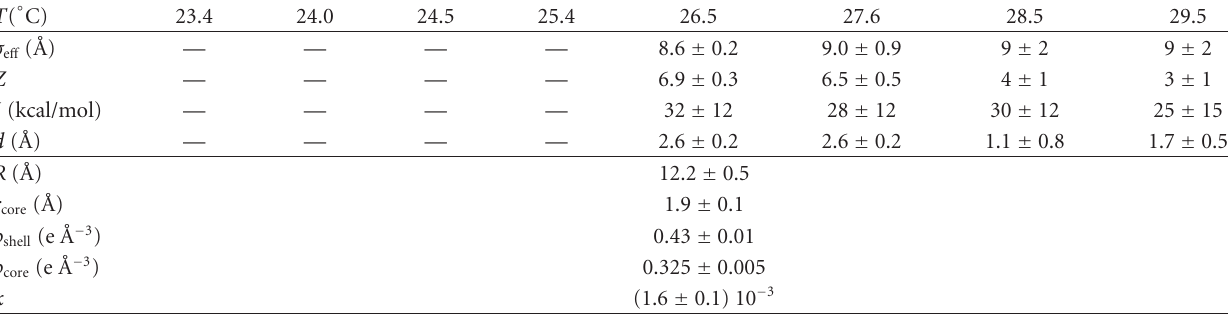
Table 2: Single and common parameters obtained by the global-fitting procedure applied to the 8 experimental SAXS curves shown in Figure 2. Symbols are as in the text.